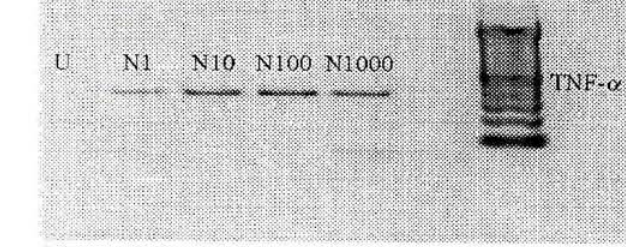
Figure 2. Qualitative analyses of tumor necrosis fac- tor-α (TNF-α) gene expression in vascular smooth muscle cells following a 3-h incubation with neopterin at increasing concentrations: 1 μΜ (NI), 10 μΜ (ΝΙΟ), 100 μΜ (Ν 100), and 1000 μΜ (Ν1000). U rep- resents unstimulated controls.